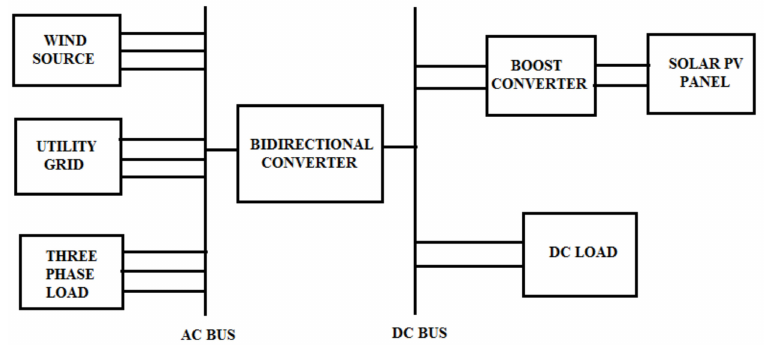
Figure 1. Hybrid microgrid